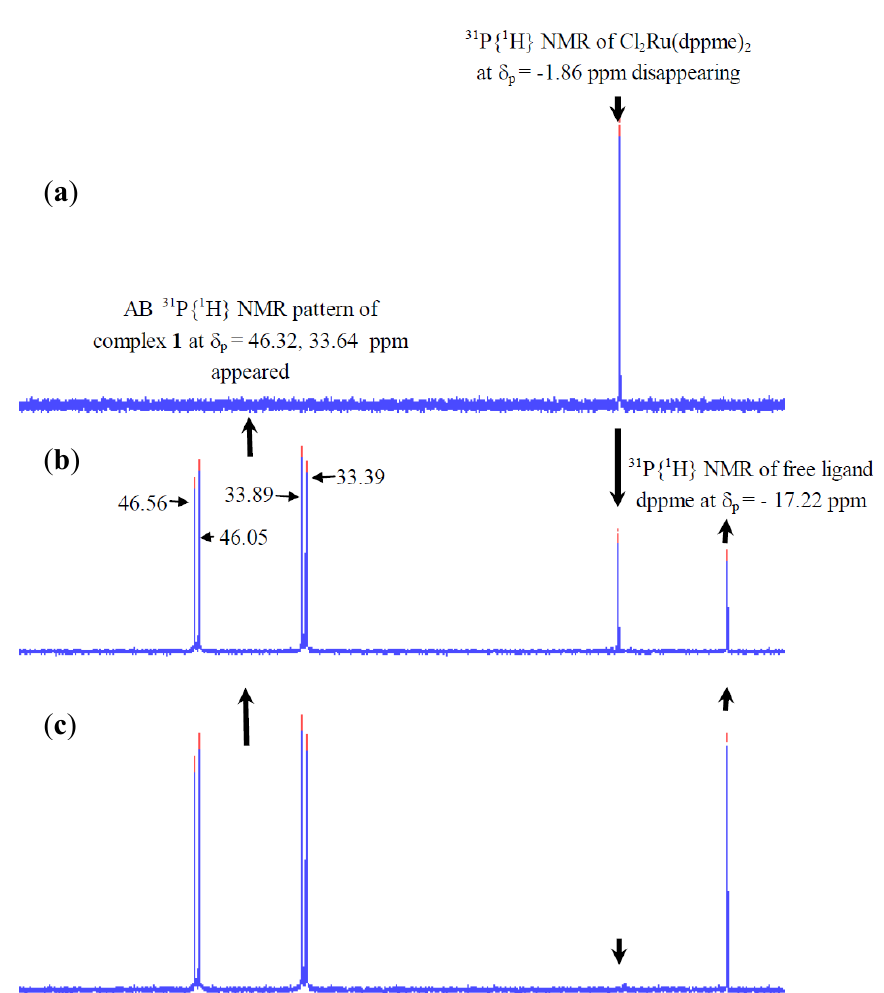
Figure 1. Time-dependent 31 P{ 1 H}-NMR spectrum of [RuCl mixed with one equivalent of [3-(2-aminoethyl)aminopropyl]trimethoxysilane co-ligand to produce complex 1 at  = 46.32, 33.65 ppm ( a ) before the co-ligand addition, ( b ) 10 min. p and ( c ) 30 min. after the co-ligand